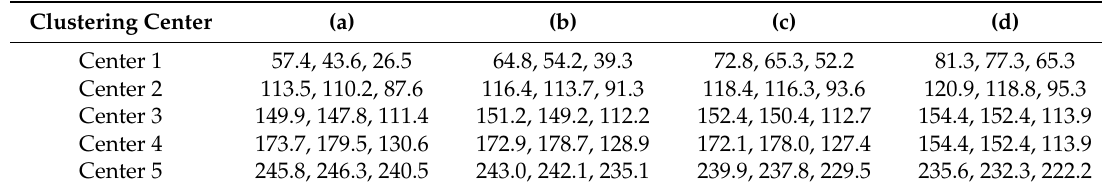
Figure 6. Segmentation results of pre- and post-event images shown in Figure 5 using FCM ( 𝑐 = 5): ( a ) pre-event image, and ( b ) post-event image.